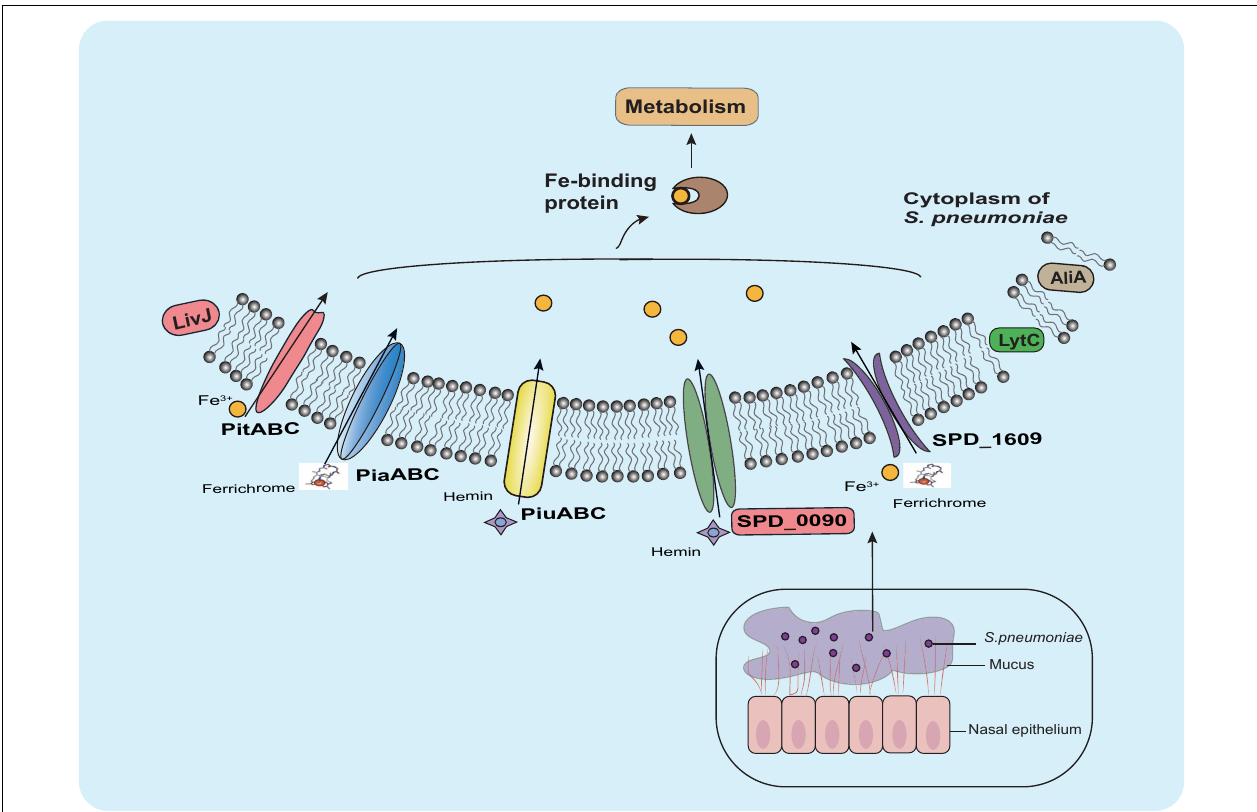
FIGURE 8 | Summary of the role of SPD_0090 in S. pneumoniae . SPD_0090, as a lipoprotein of ABC transporter and affects hemin utilization and bacterial carbon metabolism. It also affects the expression of LytC, AliA, and LivJ virulence factors, there by negatively regulating the virulence of S.